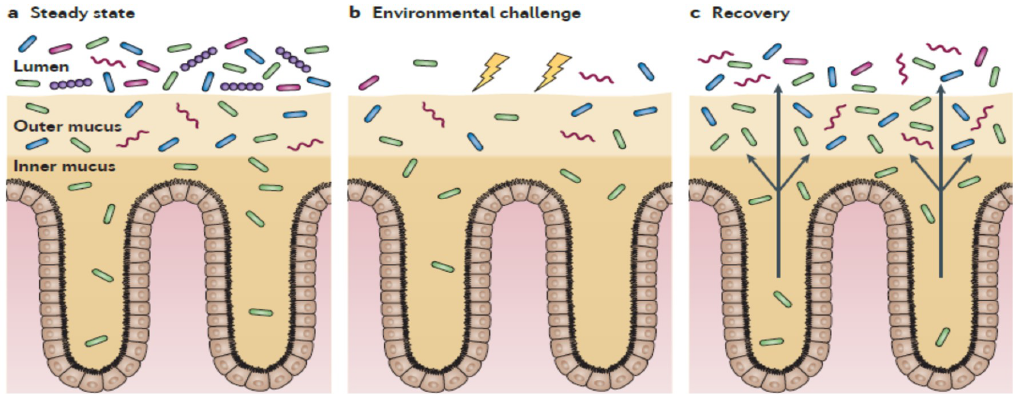
Figure 3. Gut biogeography of the bacterial microbiota [94]. ( a ) A subset of species (green) is able to